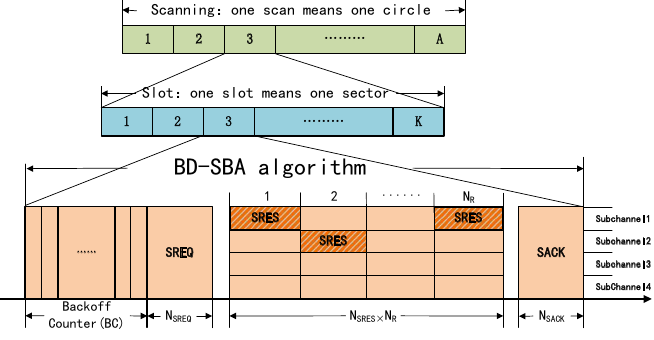
Figure 8. Algorithm frame